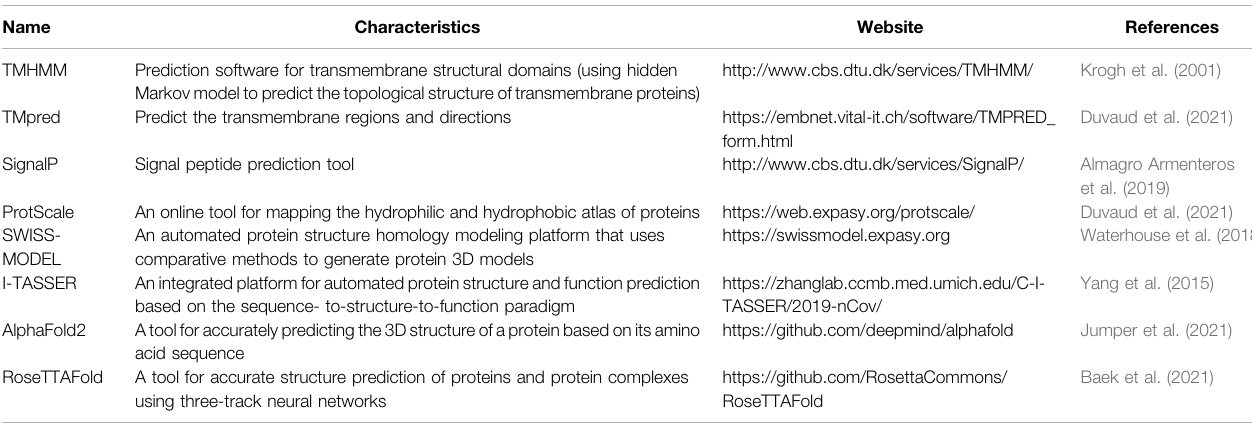
TABLE 3 | Micropeptide information and structure-related prediction